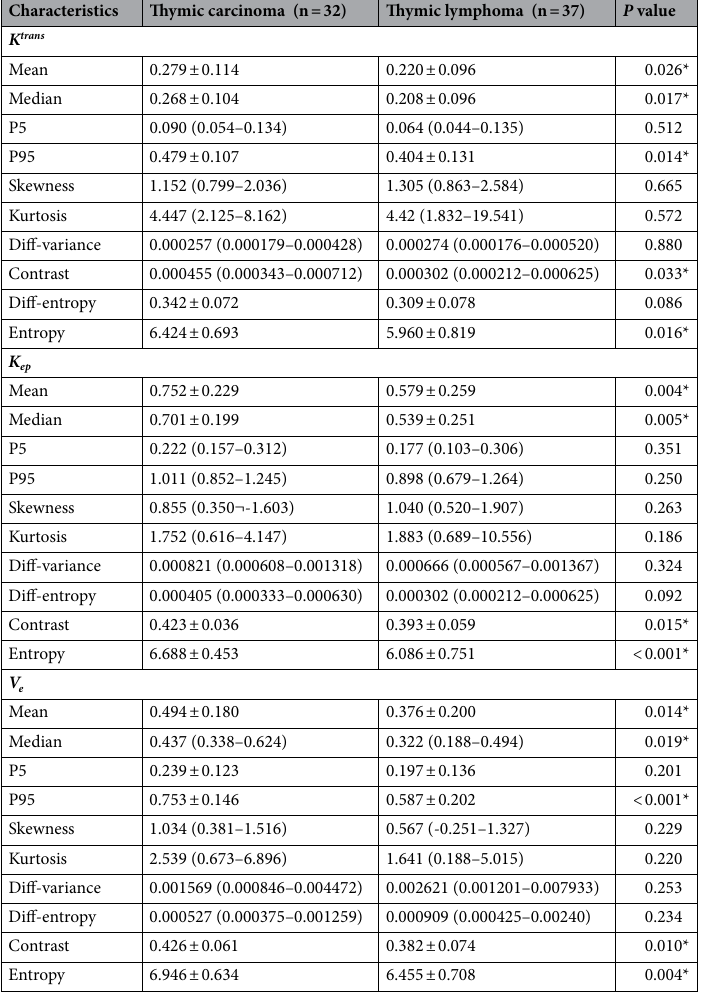
Table 2. DCE-MRI texture-derived parameters of the thymic carcinoma and lymphoma groups. *Significant differences.